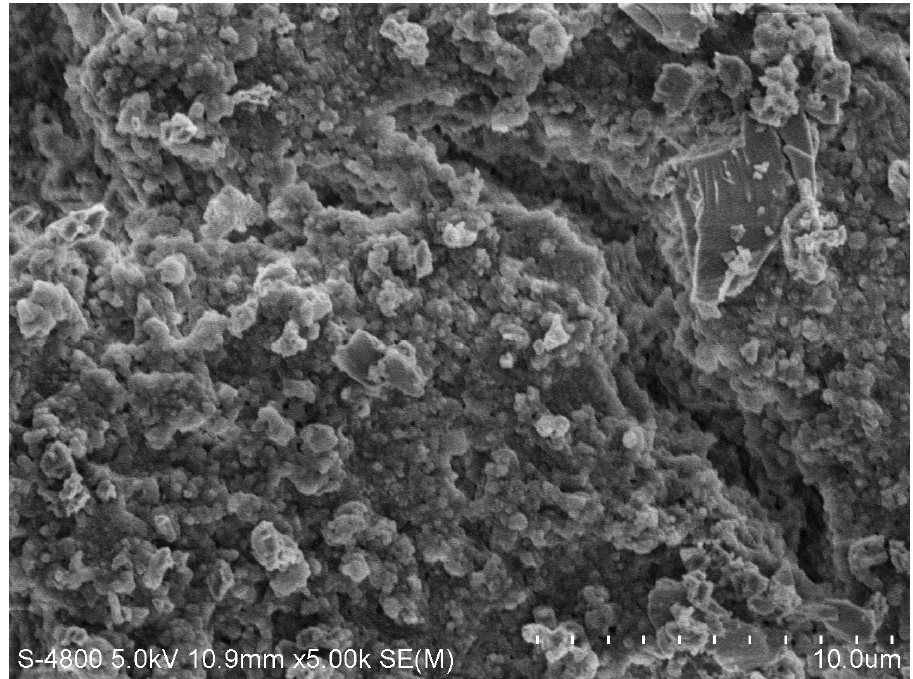
Figure 8. Photograph of the ZrO magnification